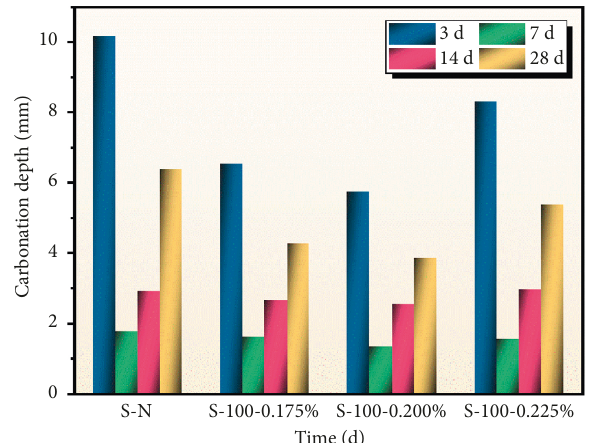
Figure 8: Carbonation depth of concrete with SAP of different dosages.